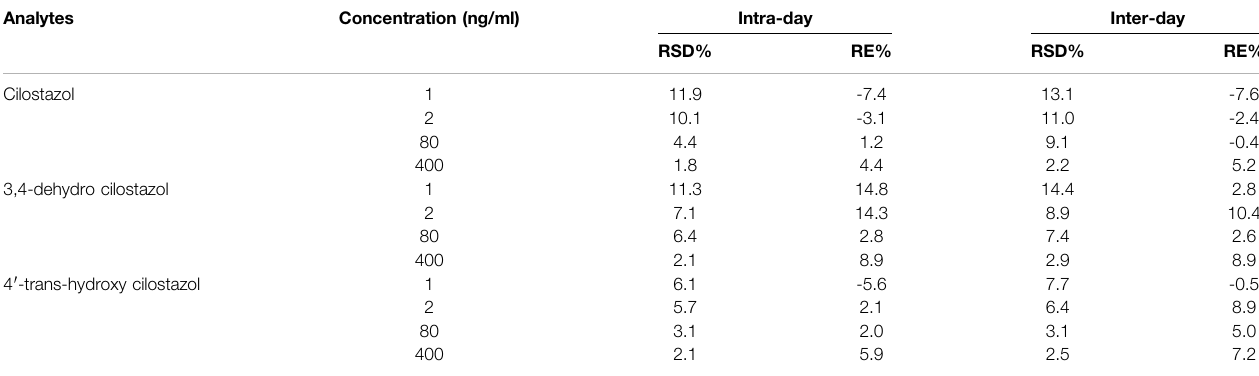
TABLE 3 | Precision and accuracy of cilostazol and its metabolites in rat plasma ( n = 6).